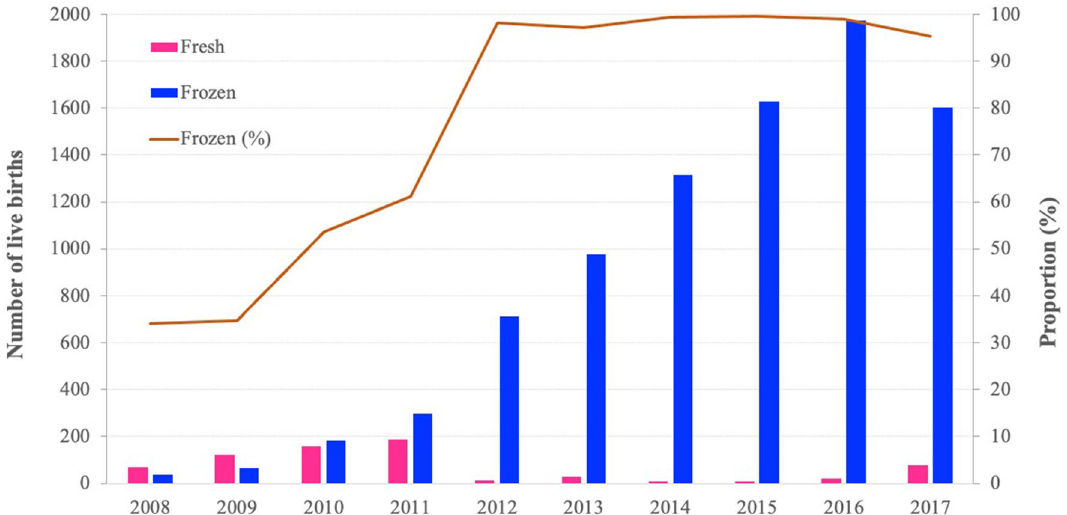
Figure 2. The trends of live births by fresh- and frozen-embryo transfer. From 2008 to 2017, there was increased in trend in the proportion of frozen-embryo transfer (Cochran−Armitage trend test χ 2 = 41.06, P <